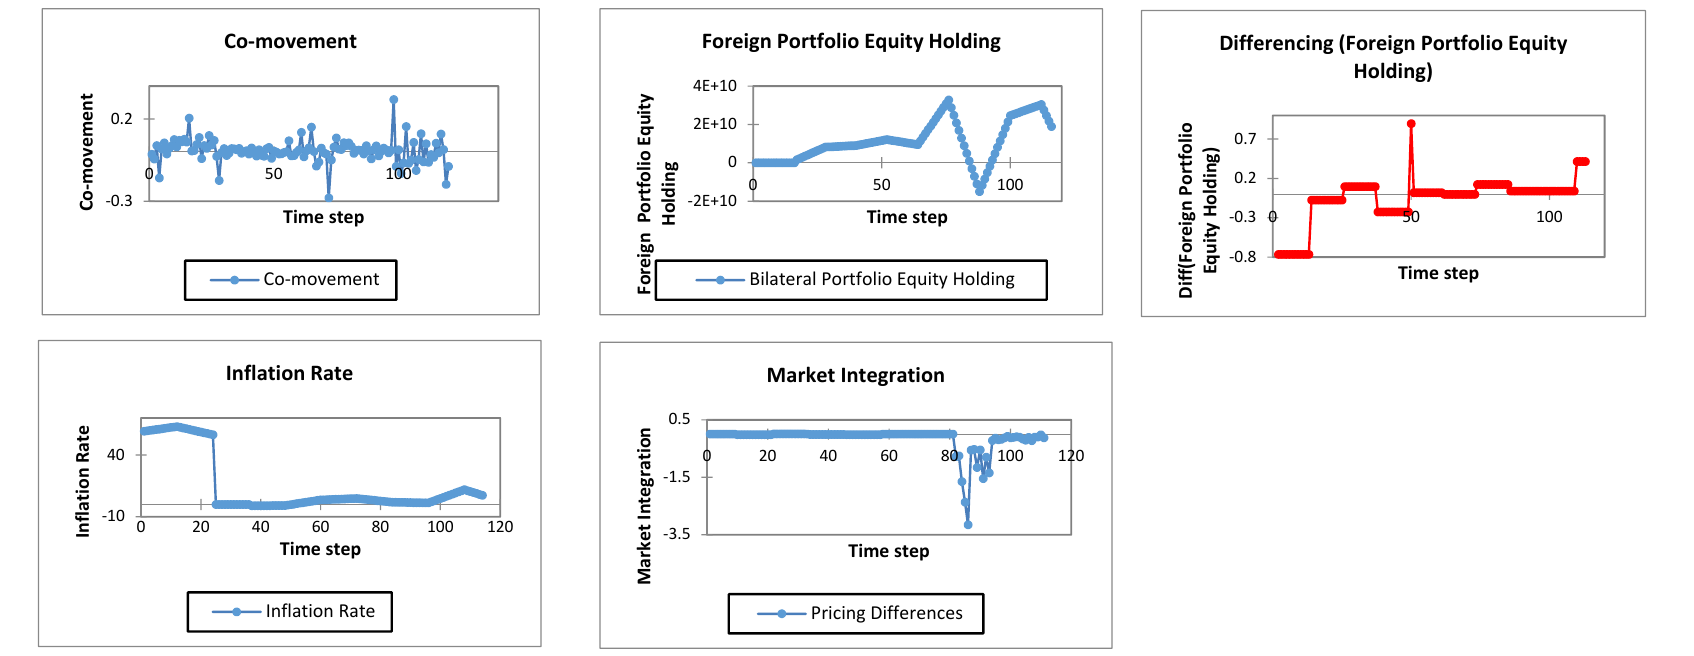
Figure 1. Stationarity Test for Pakistan-India Bilateral Variables from 2003–2012.